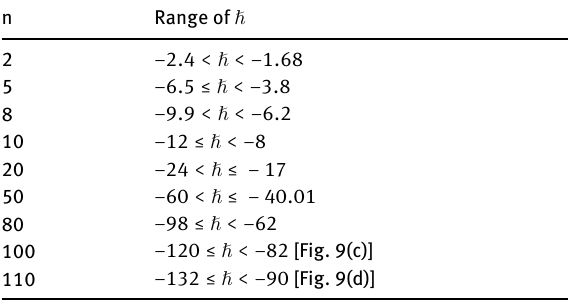
Table 1: The fourth order absolute converge range of Eq. (44) de- cided from (cid:126) -curves at x = 0.5, t = 0.02, α = 1 and k = 0.03